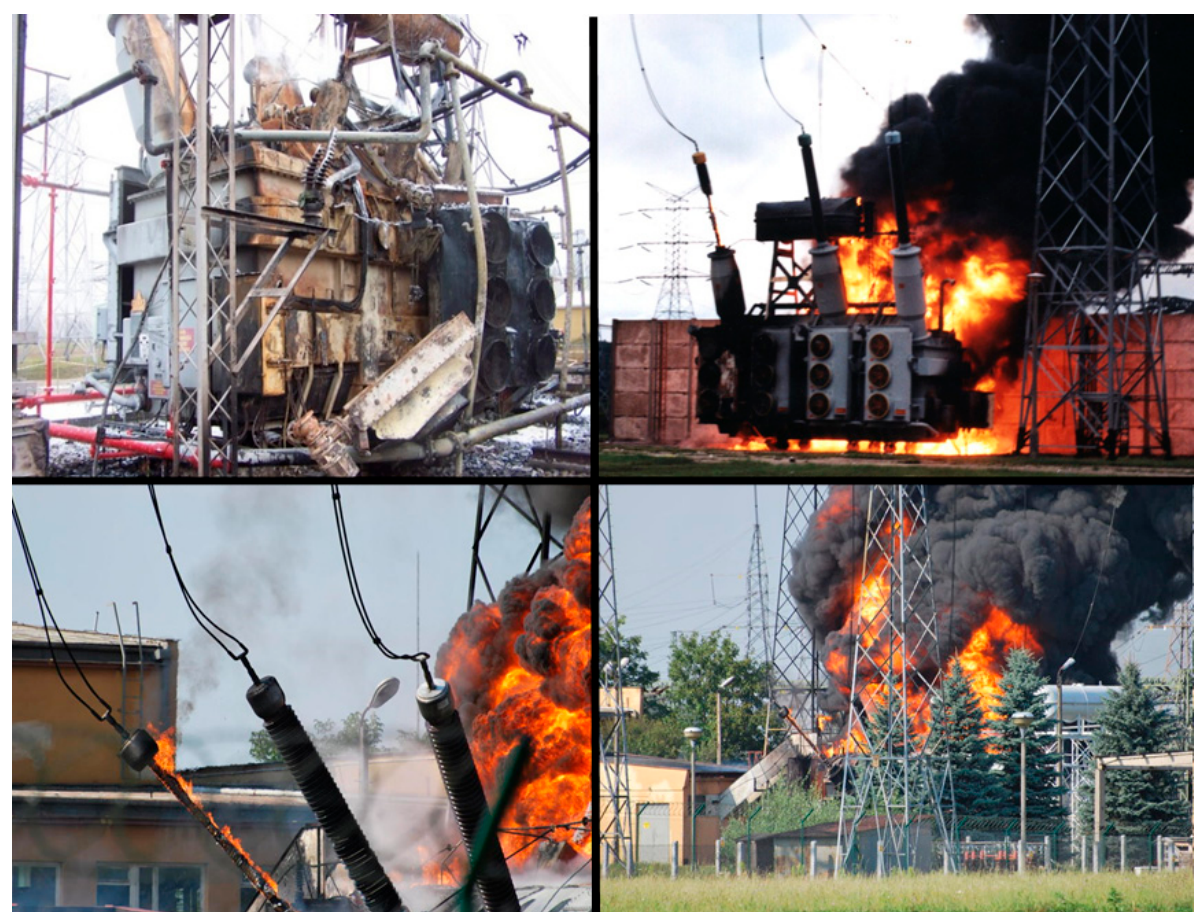
Figure 2. Examples of catastrophic failures of high power transformers initiated by the failure of a bushing.